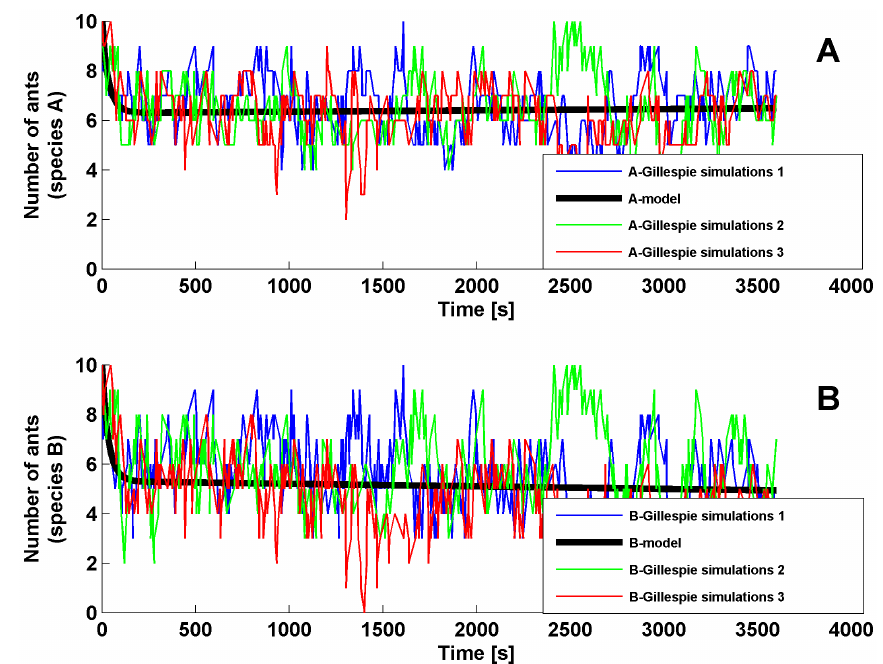
Figure 6. Stochastic time series. Temporal variation of the A (A) and B (B) chemical species, obtained from three simulations of the stochastic model. Predictions of the deterministic model are also shown (black line).